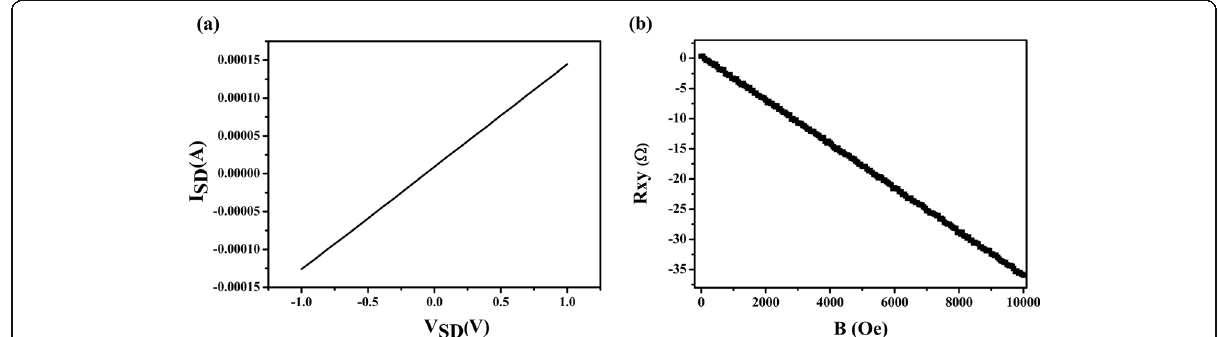
Fig. 8 a A representative current-voltage ( I SD - V SD ) curves of the graphene dendrites at zero gate voltage. b Hall resistances as a function of magnetic field strength for graphene